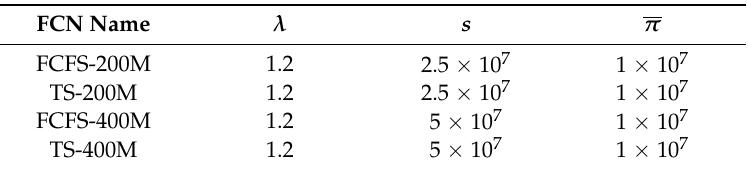
Table 2. Parameters of Simulation